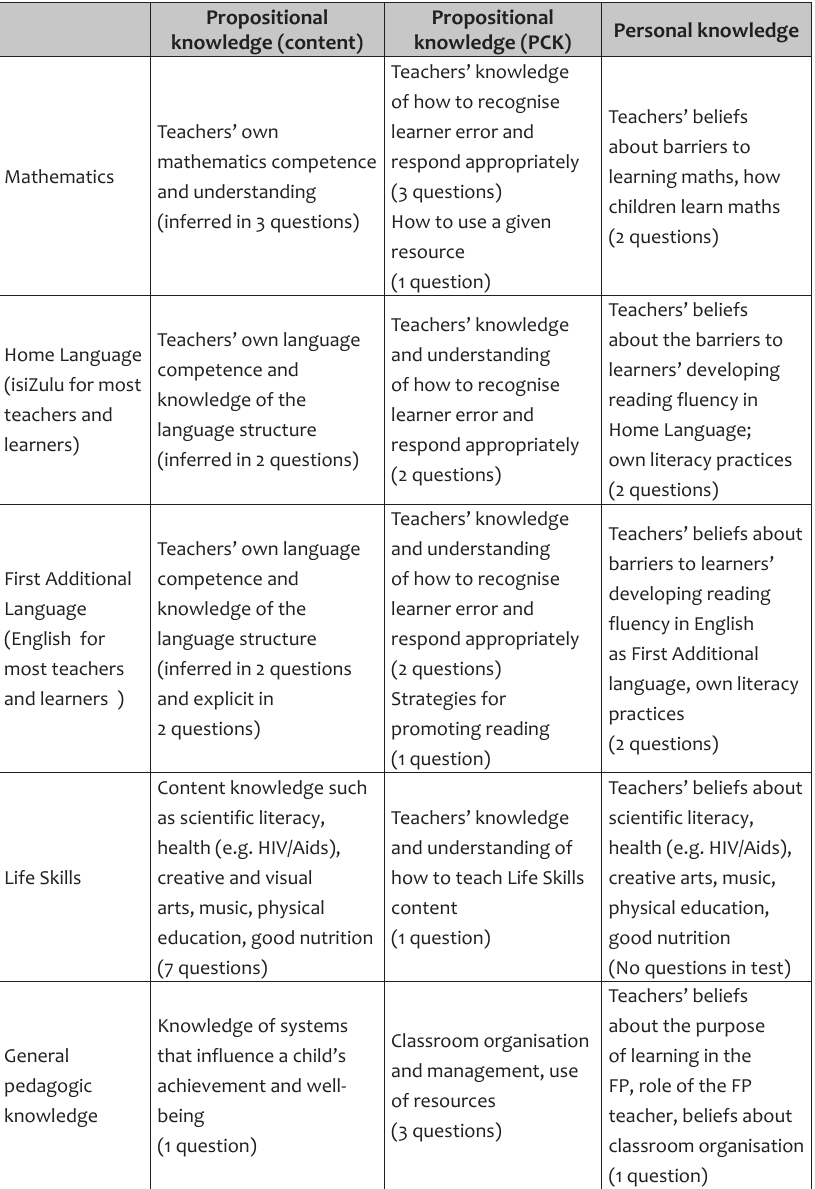
Table 1: Distribution of questions across the knowledge domains and FP learning areas for the first